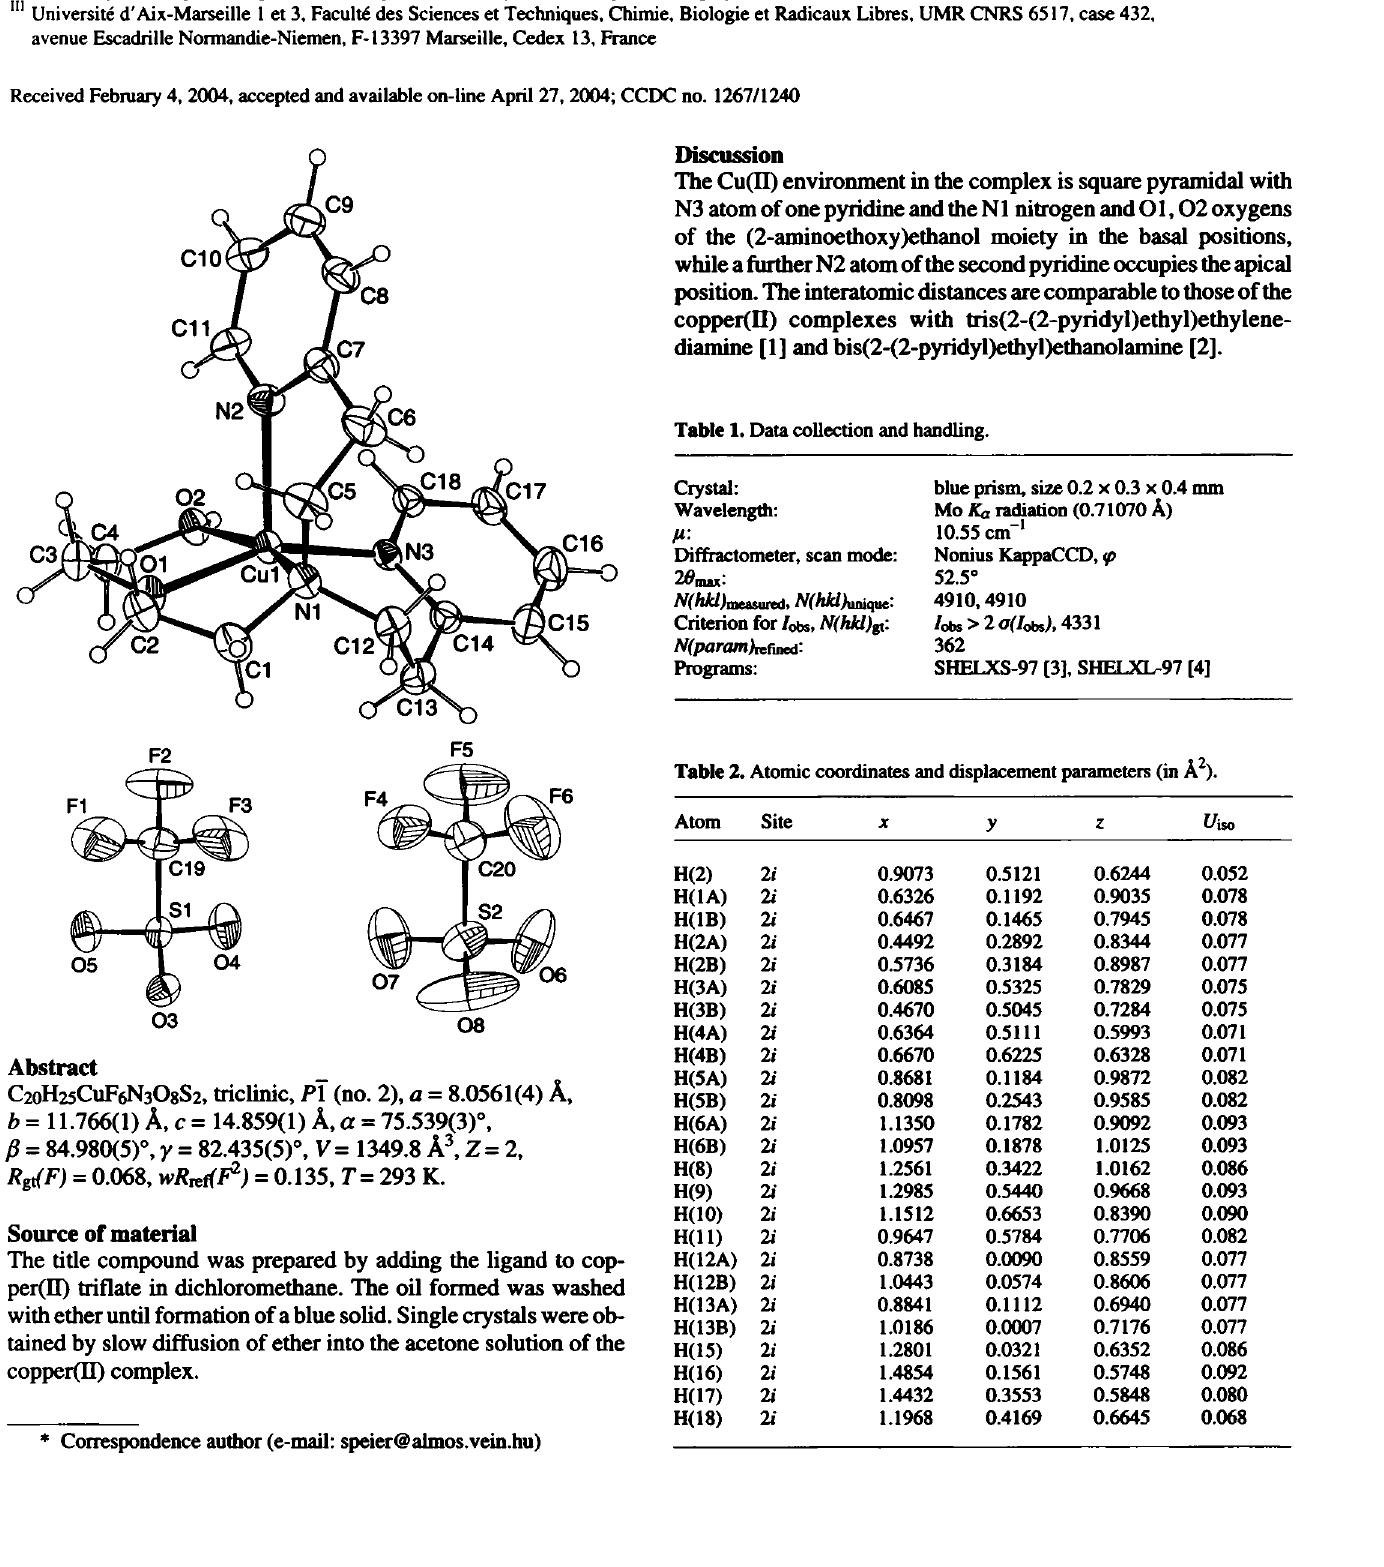
Table 1. Data collection and handling.